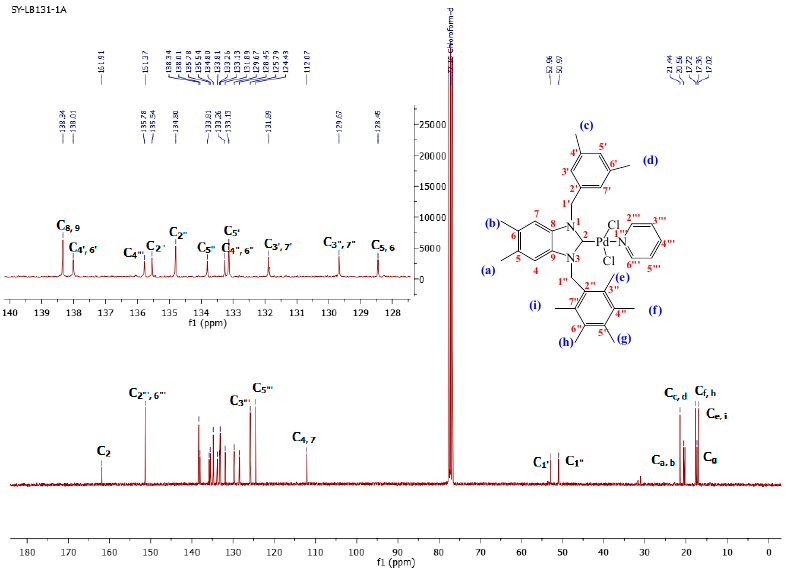
Figure 4. 13 C-NMR spectrum of palladium PEPPSI-type complex 3a in CDCl 3 .